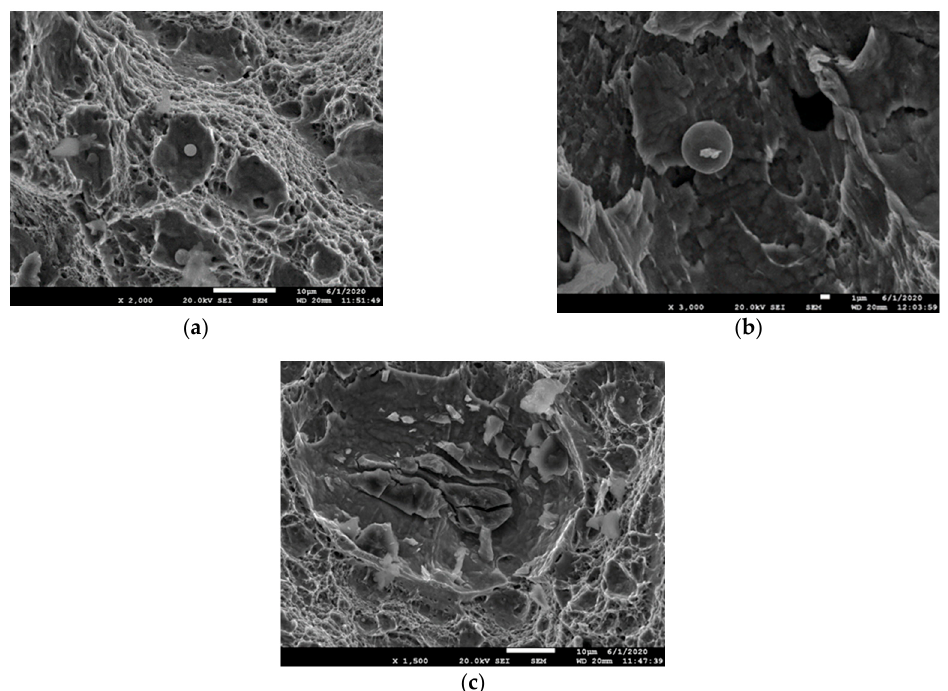
Figure 8. Fractured surface images of the chessboard family 2 (Samples 13–15) with ( a ) ductile dimples, ( b ) oxide inclusions and unmelted particles in a large dimple, and ( c ) oxide inclusions.